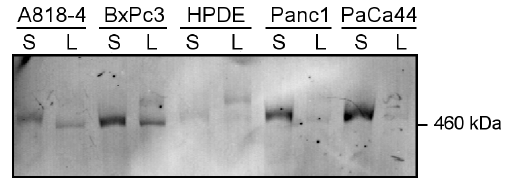
Figure 1. Fat1 cadherin in secretome and lysate fractions of pancreatic cancer cell lines. Western blot analysis of Fat1 in the respective secretome (S; 8 m g loaded) and lysate (L; 50 m g loaded) fractions from four pancreatic cell lines and HPDE. The blot was probed with an antiserum raised against the extracellular domain of Fat1